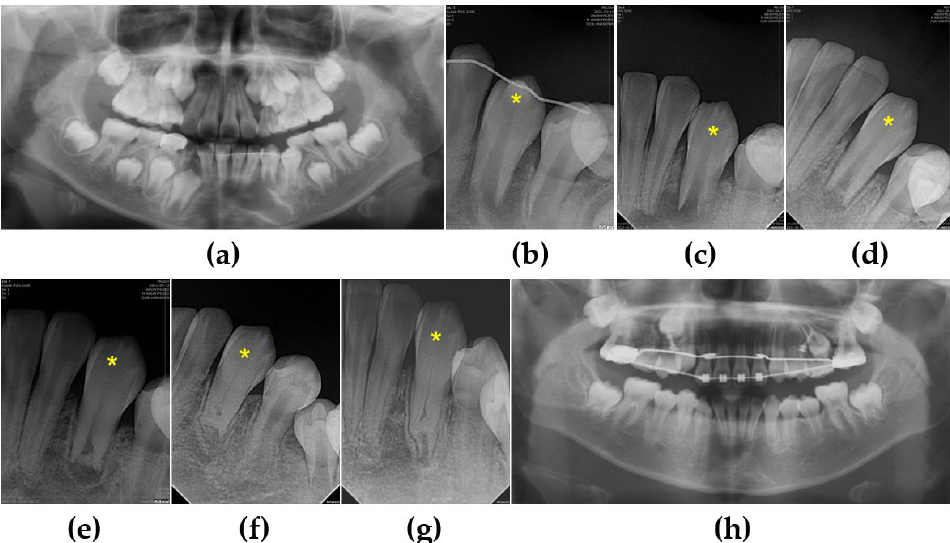
Figure 4. Radiographic findings. The transplanted tooth is marked with a yellow asterisk (*). Radi- ographs were taken on the day of autotransplantation ( a , b ), 1 month ( c ), 3 months ( d ), 6 months ( e ), 12 months ( f ), and 18 months ( g , h ) postoperatively.